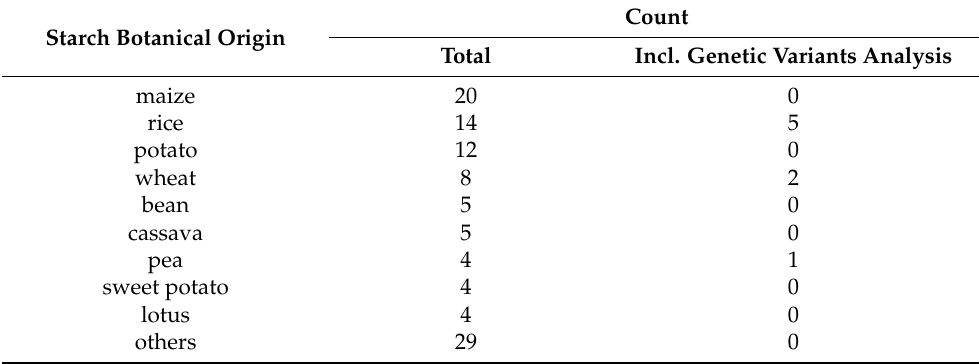
Table 2. Type of sample used in the panel of papers.